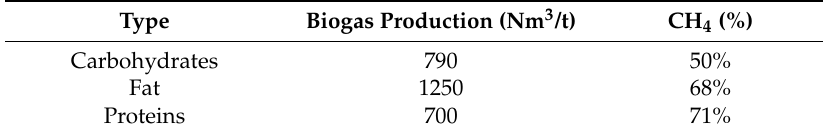
Table 4. Biogas and methane fraction generation for each organic material type (data from